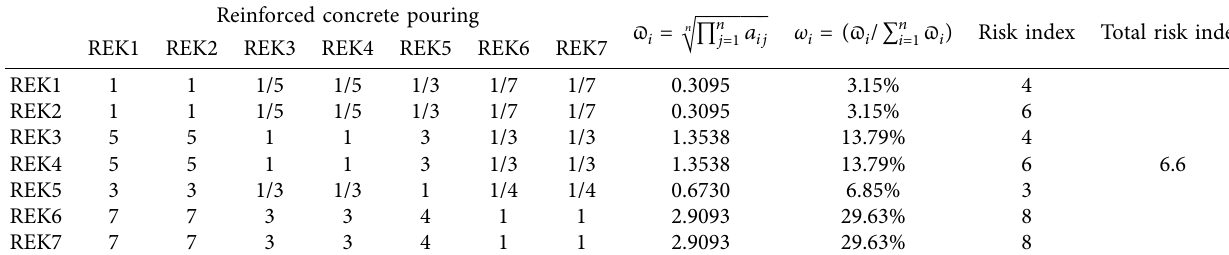
Table 30: Risk judgment matrix of reinforced concrete pouring.